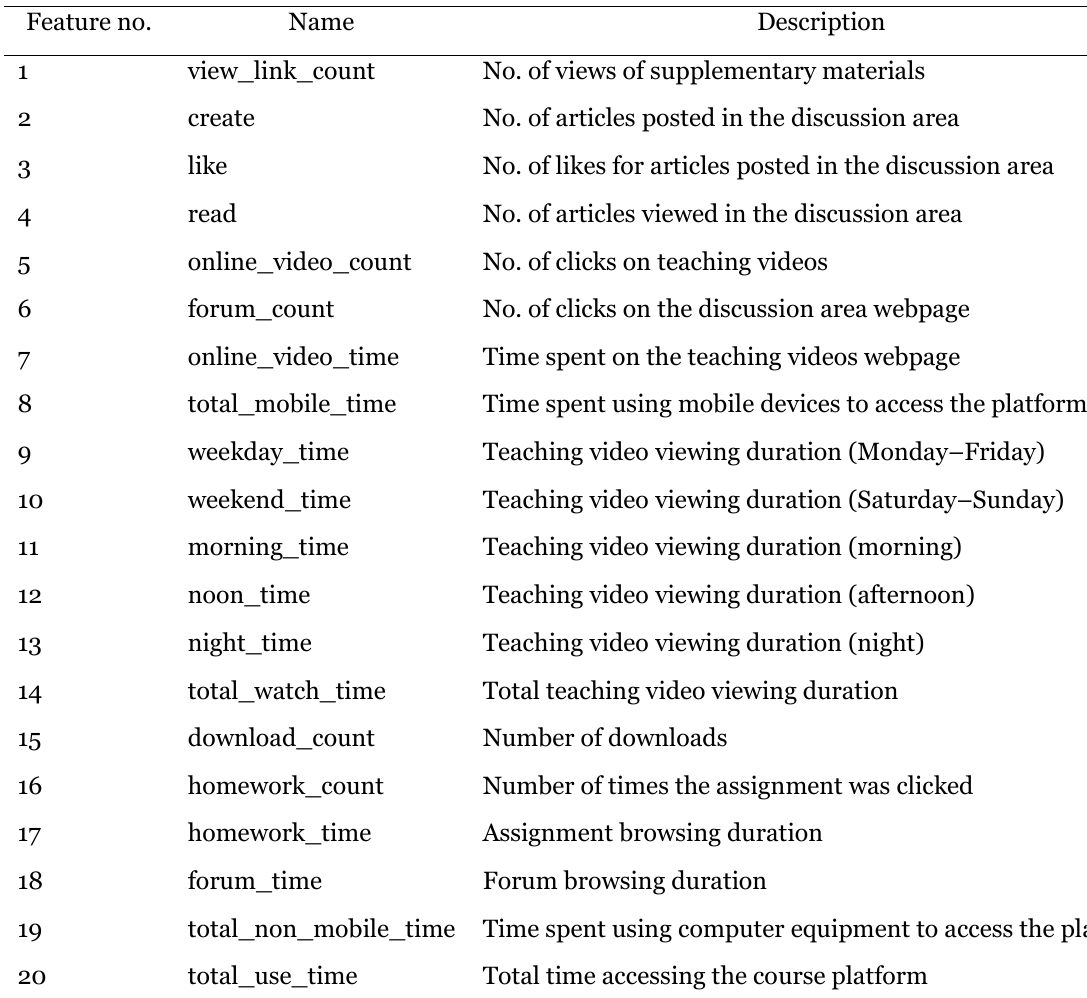
Table 2 Description of Features Used in the Prediction Models Feature